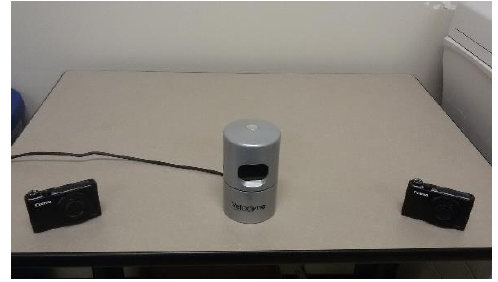
Figure 2. The first scenario for the sensors